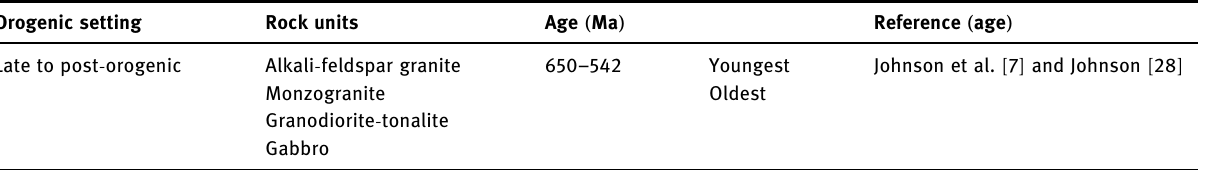
Table 1: Geochronology of the basement rocks in the study area